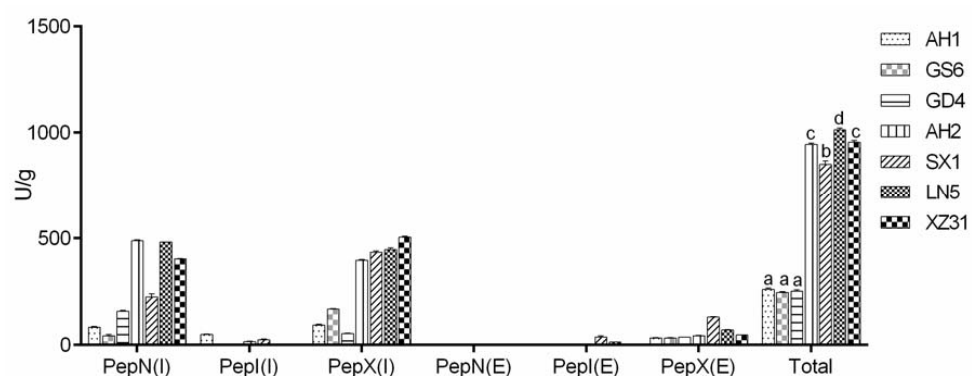
Figure 2. PepN, PepI, and PepX activities of seven lactic acid bacteria strains on Leu- p -nitroanilidies, Pro- p -nitroanilidies, and Gly-Pro- p -nitroanilidies substrates, respectively. (I) and (E) indicate intracellular and extracellular enzyme activities, respectively. Bars that do not share a common lowercase letter differ significantly ( p < 0.05) ( n = 3).